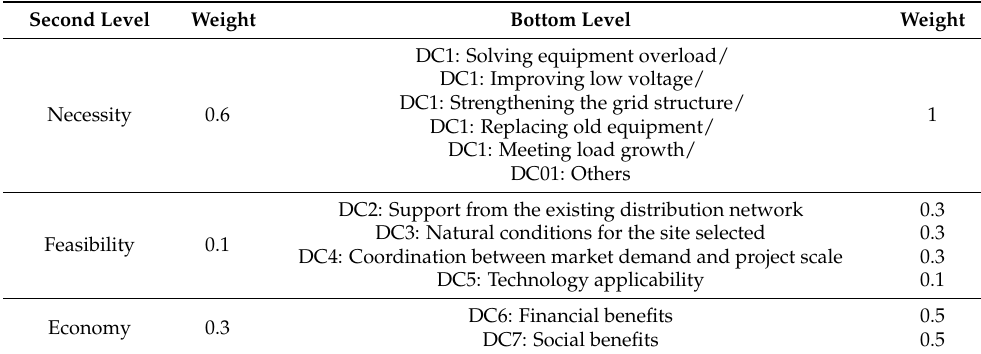
Table 4. The hierarchical evaluation structure of dominant conditions for Xiantao ADN.